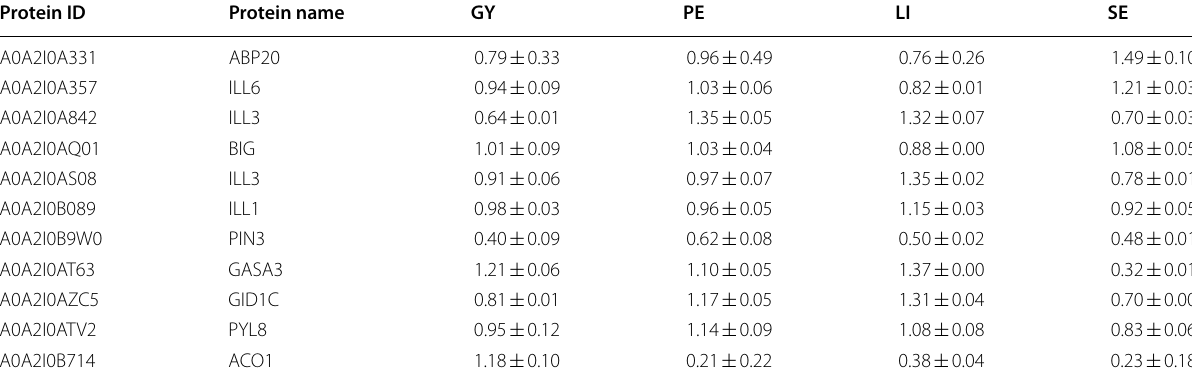
SE: Sepal; PE: petal; LI: lip; GY: gynostemium